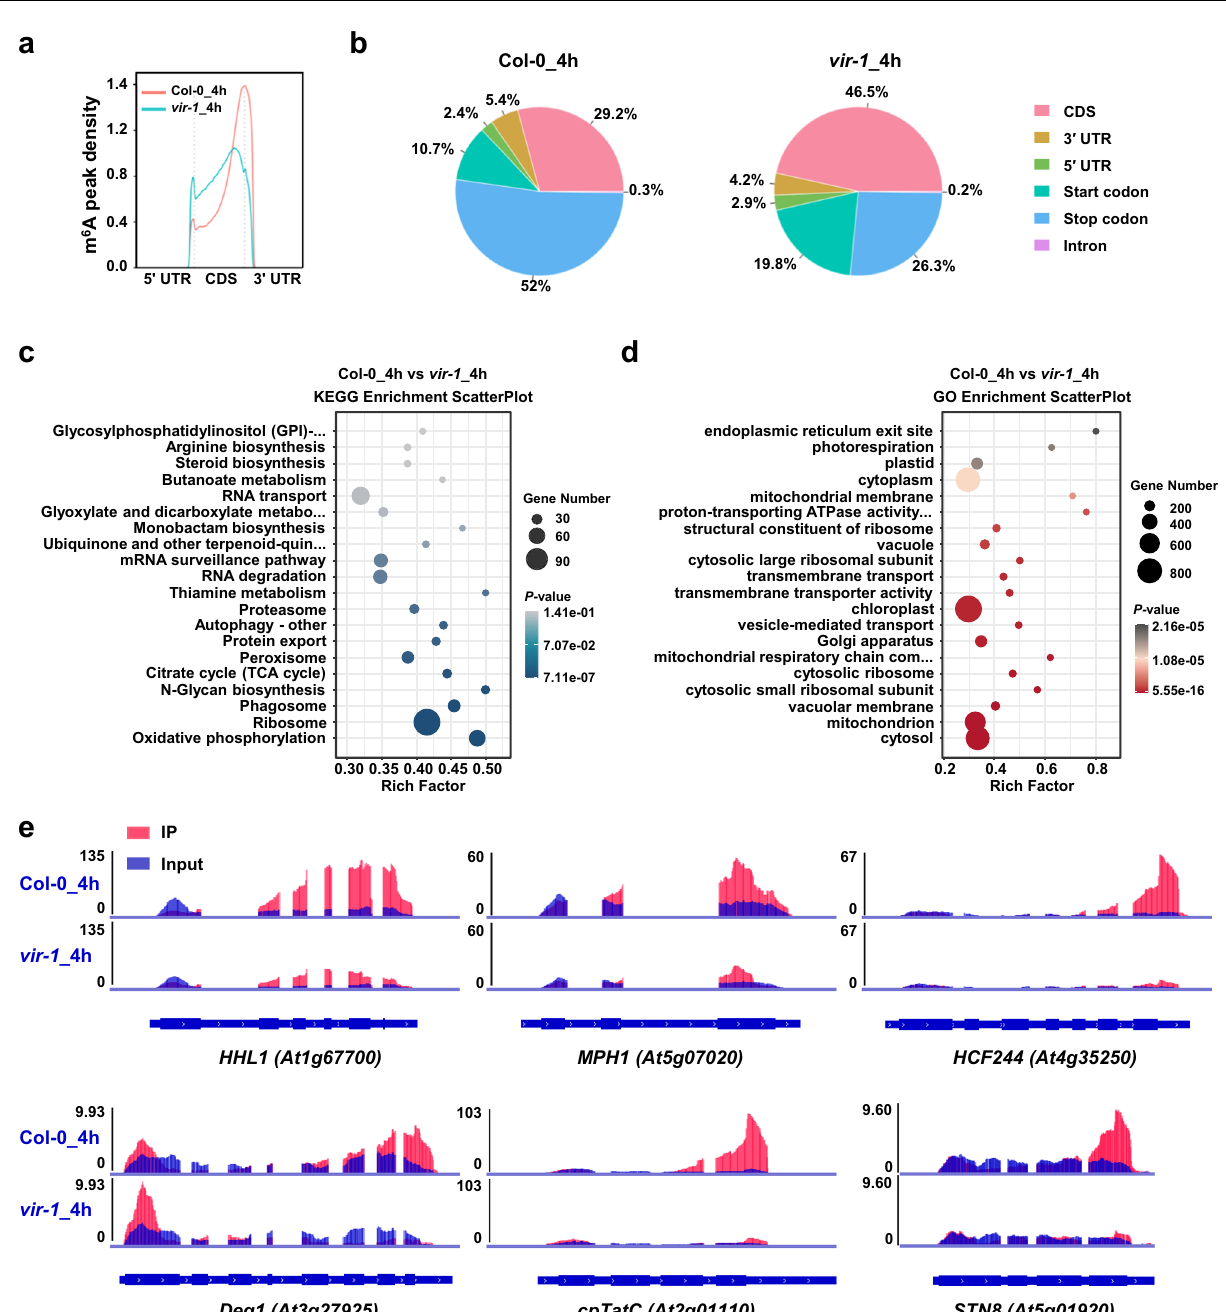
Fig.4|Comparisonofm 6 Amodi fi cationbetweenCol-0and vir-1 seedlingsafter high light treatment. a Comparison of the distribution of m 6 A peaks along tran- script segments in Col-0 and vir-1 seedlings after a 4-h high light (HL) treatment. b Comparison of the distribution of m 6 A peaks in different segments of Col-0 and vir-1 transcriptsaftera4-hHLtreatment.CDS,codingsequence;UTR,untranslated region. c KEGG analysis of VIR-dependent m 6 A-containing genes after a 4-h HL